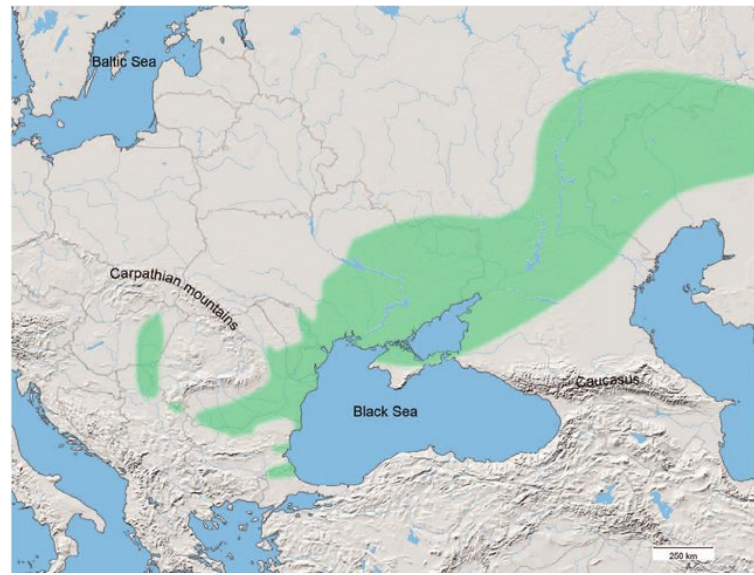
Figure 1. Geographical range of the Yamnaya Culture [17].